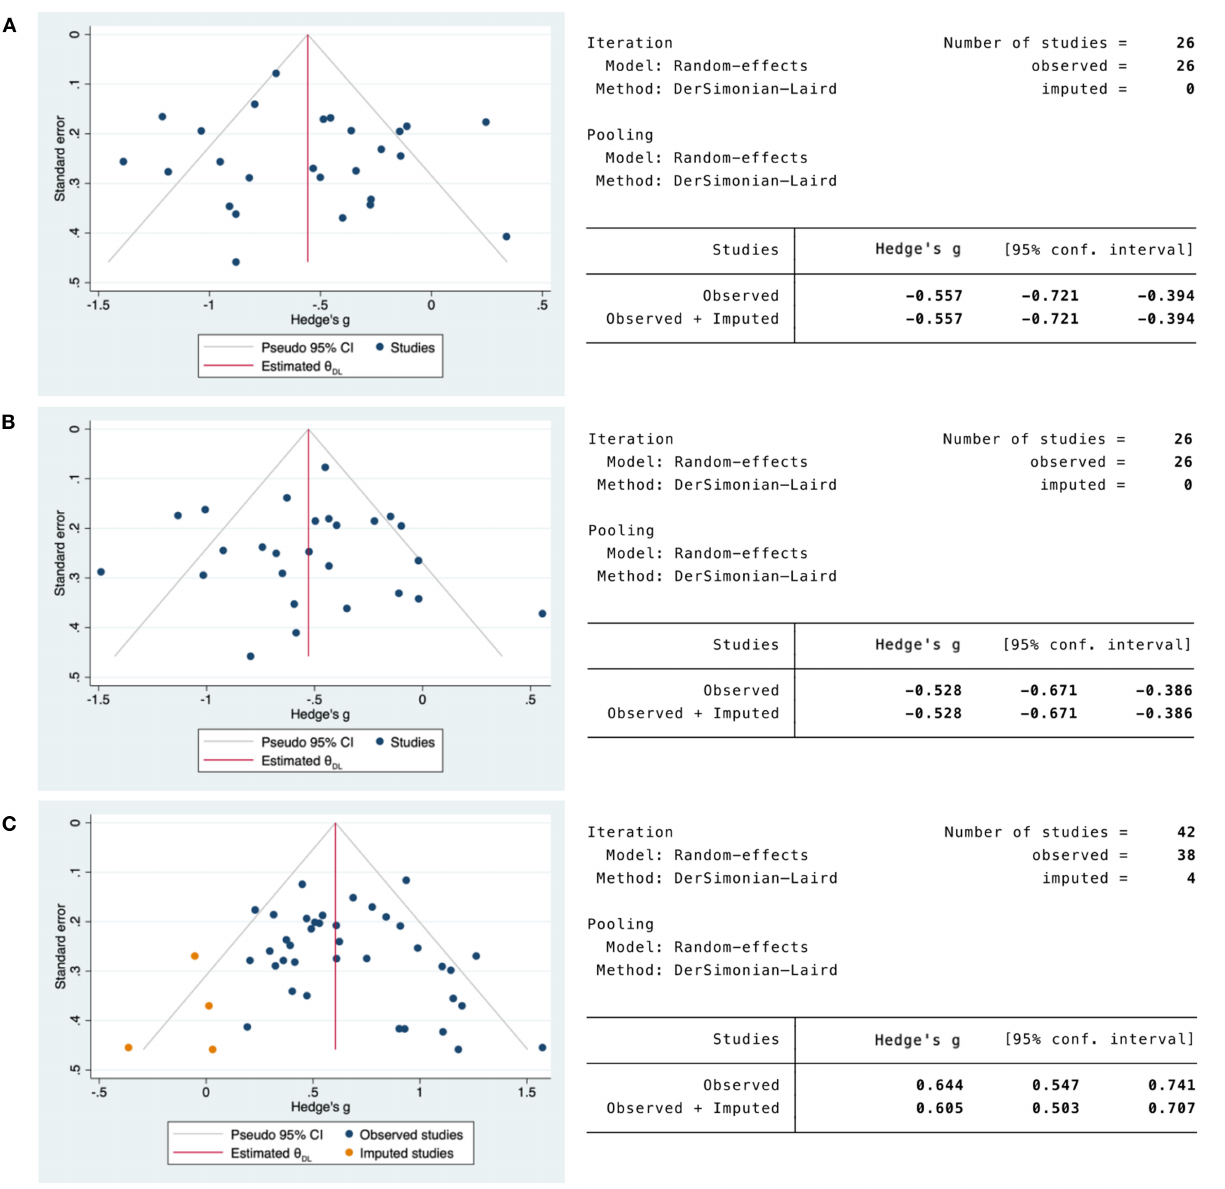
Results from each study in the mortality group contributed similarly to the overall result of the combined effect size [SMD = − 0.70 to − 0.77 for CD4 T-cell studies ( Supplementary Figure 12.4 ), (SMD = − 0.32 to − 0.63 for CD8 T-cell studies ( Supplementary Figure 12.5 ), and SMD = 0.82 to 0.69 for IL-10 studies ( Supplementary Figure 12.6